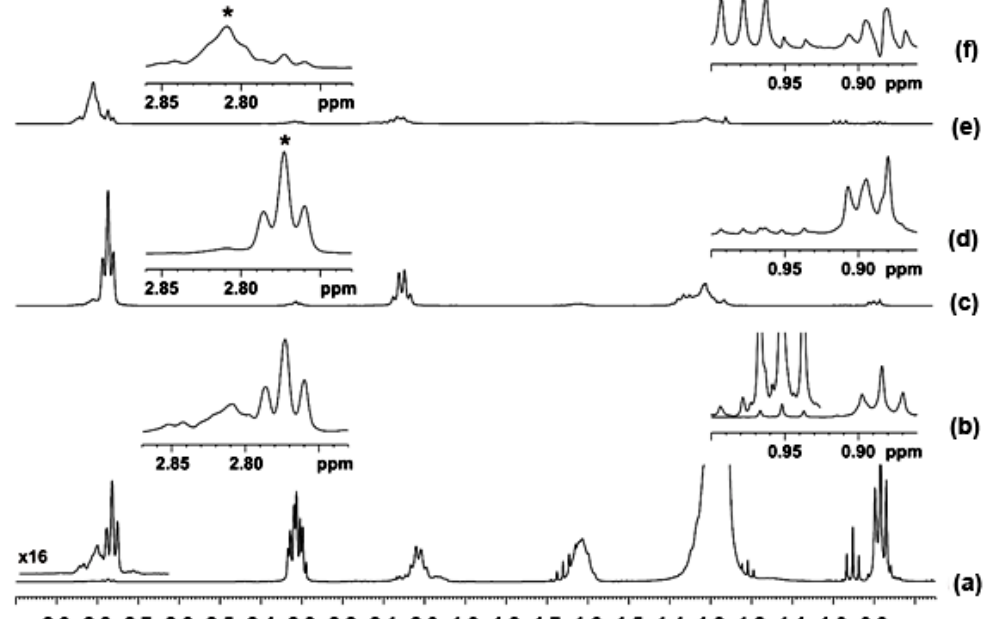
Figure 1. ( a ) Selected region of a 500 MHz 1 H-NMR spectrum of the lipid fraction of a lyophilized bovine milk sample in CDCl 3 . ( b ) Magnification of the respective 1 H-NMR regions T= 298 K; number of scans, 256; acquisition time 4.3 s; relaxation delay, 5 s; total experimental time ~25 min). ( c ) and ( e ) 1D TOCSY spectra; ( d ) and ( f ) are the magnification of the respective 1 H-NMR regions, τ m = 200 ms, number of scans, 256 and total experimental time ~25 min; the asterisks (*) denote the resonances of the allylic protons that were excited with the use of a selective shaped pulse of 80 ms.